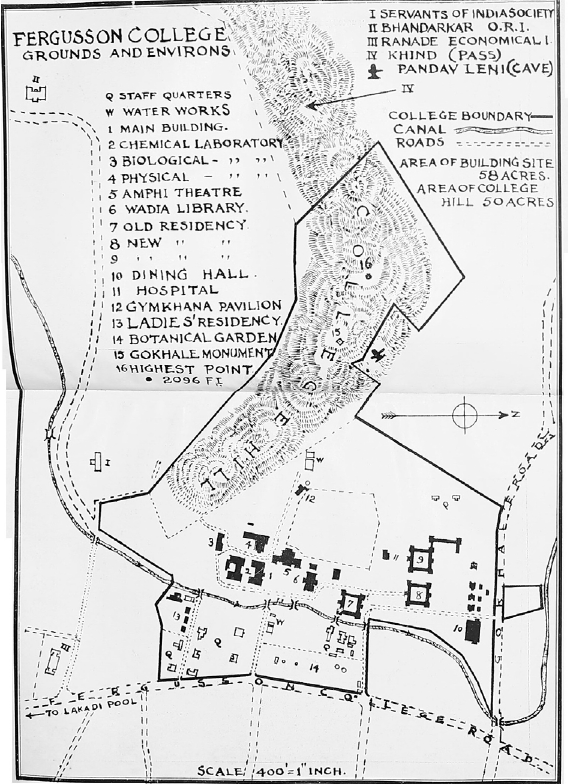
Figure 2. Study area with prominent landmarks (from Limaye 1935). Notice the Mutha canal marked in the map. Also, the point marked as ‘khind’ represents the present day Senapati Bapat road that led to fragmentation of this